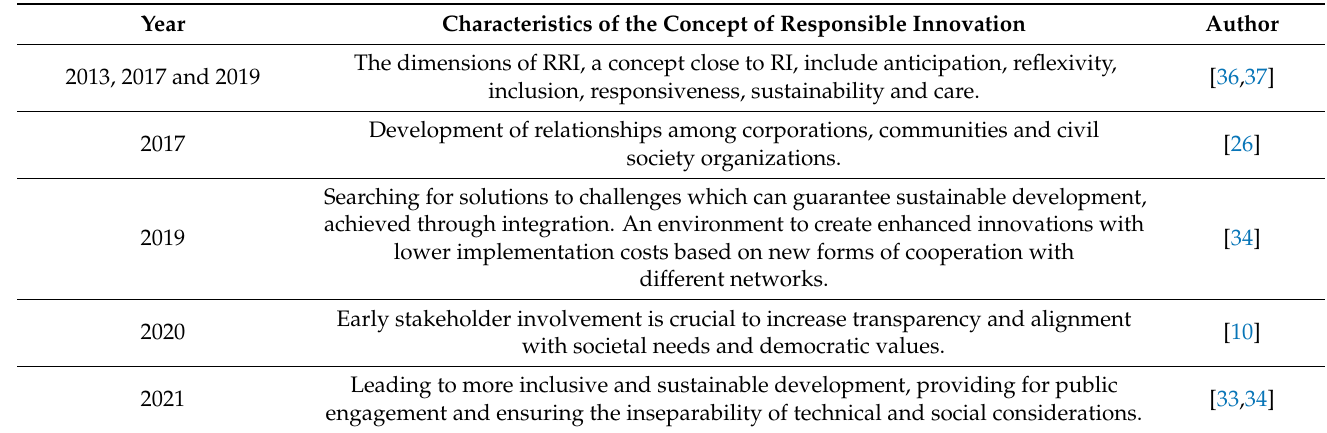
Table 3. The characteristics of the concept of responsible